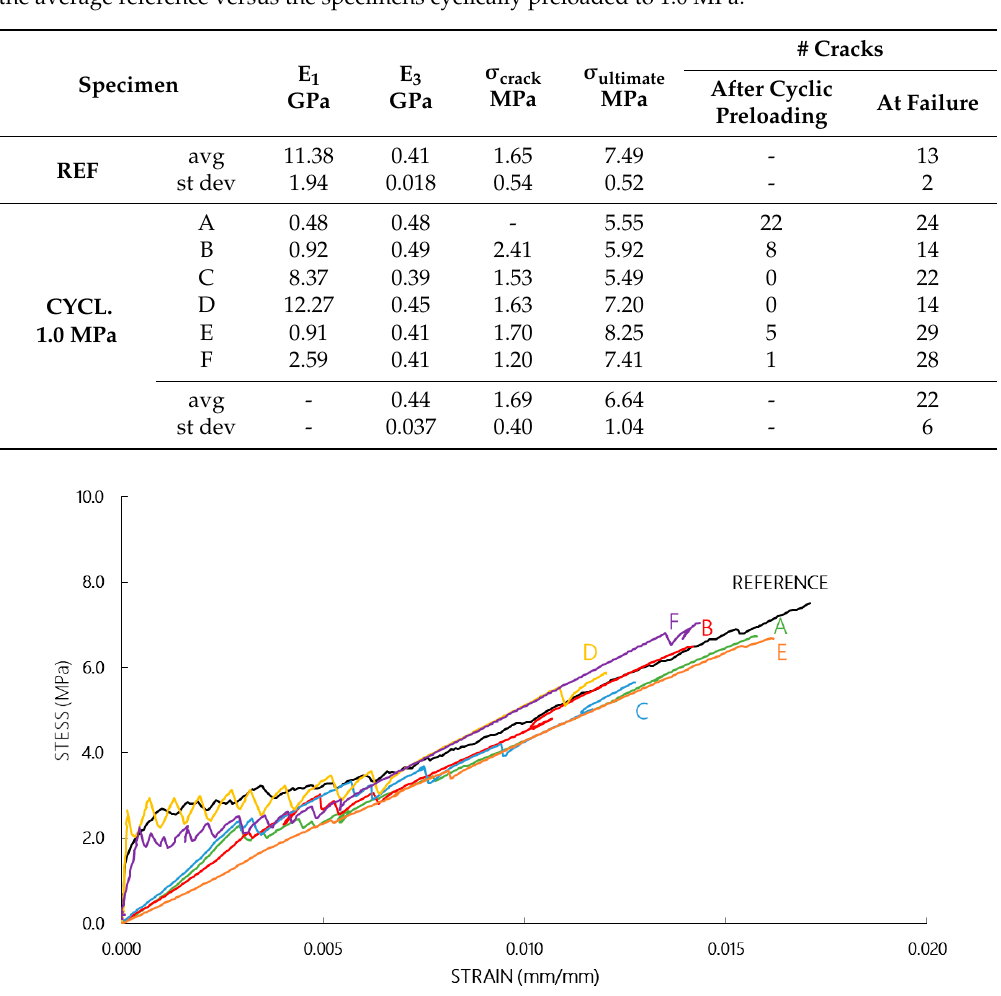
Figure 12. Residual behavior of TRC CYCL. 2.0 MPa. Table 8. Quantitative comparison of some distinctive parameters of the static tensile stress–strain curve: the average reference versus the specimens cyclically preloaded to 2.0 MPa.